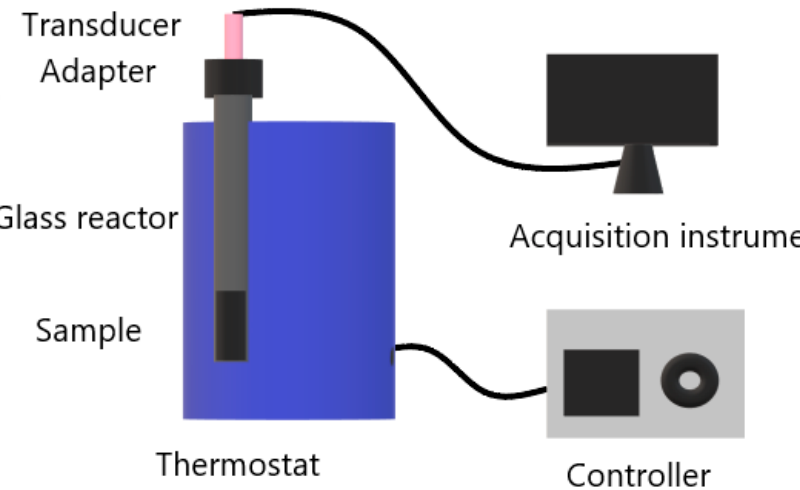
Figure 1. The schematic diagram of the instrument for measuring gas pressure.